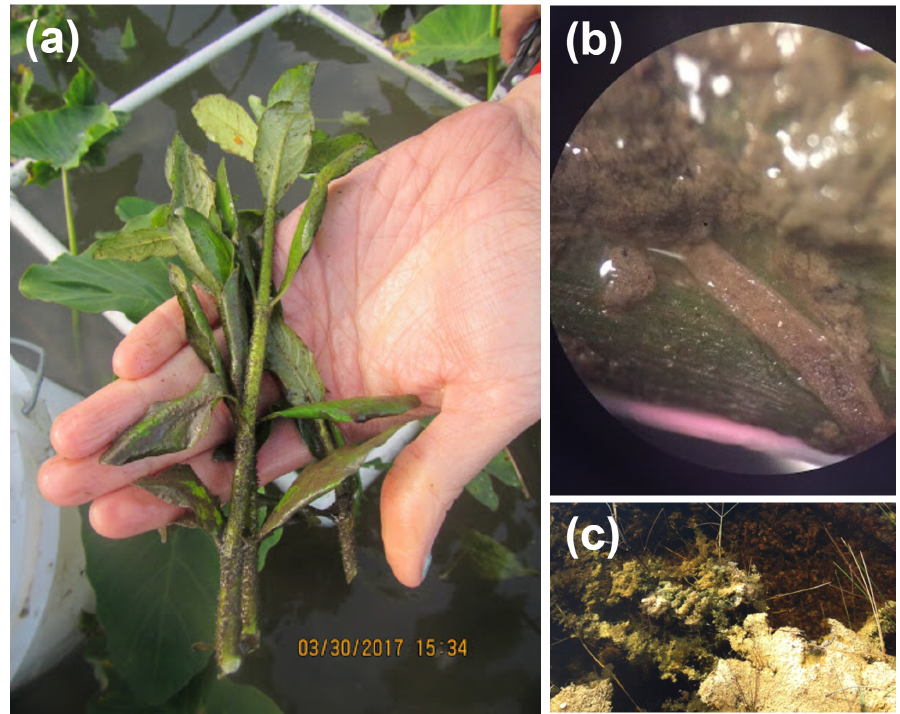
Figure 1. Photographs of fine sediment captured on vegetation in a field setting. ( a ) Stems obtained from a tidal freshwater marsh within the Wax Lake Delta, southern Louisiana. ( b ) A magnified (10 × ) image of one of these stems. ( c ) In places like the freshwater nontidal Everglades, Florida, fine sediment is often captured by thick coatings of epiphyton on vegetation